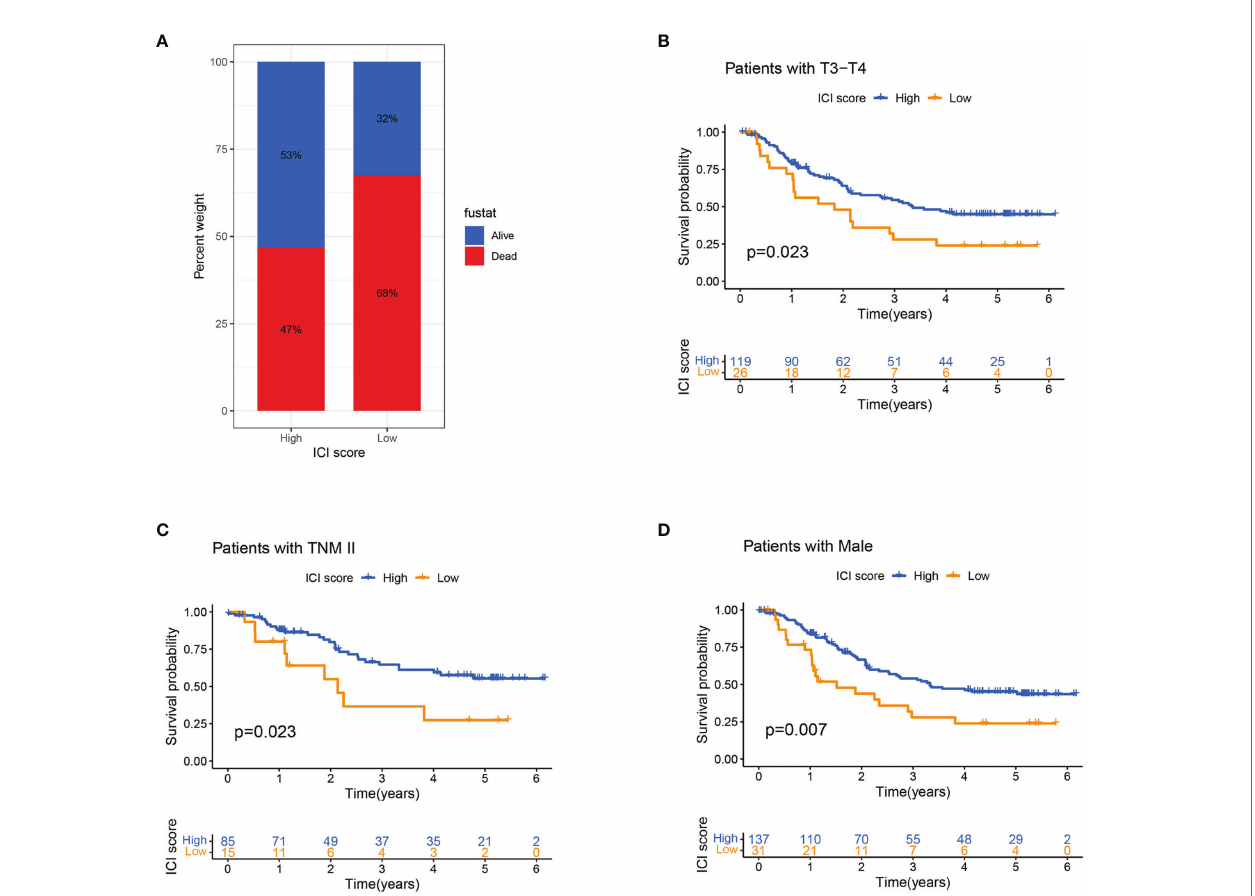
FIGURE 5 | Association of ICI score and clinicopathological features. (A) Survival rates of patients with ESCC in high and low ICI score groups. (B – D) Kaplan – Meier curves for high and low ICI score groups in patients with T3 – T4 stage (B) and TNM II stage (C) and in male patients (D) in the entire